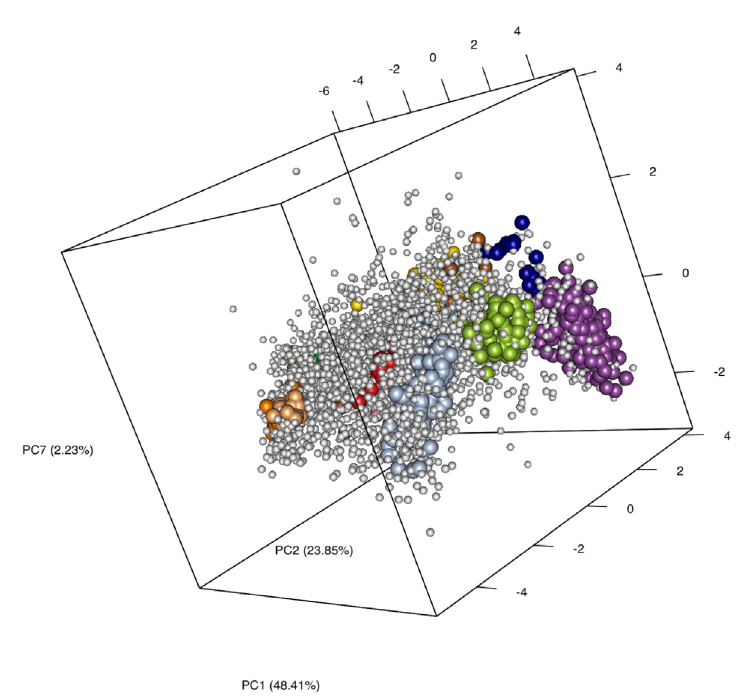
Figure 9. Using the plot3D function to visualise the hl dataset along PCs 1, 2 and